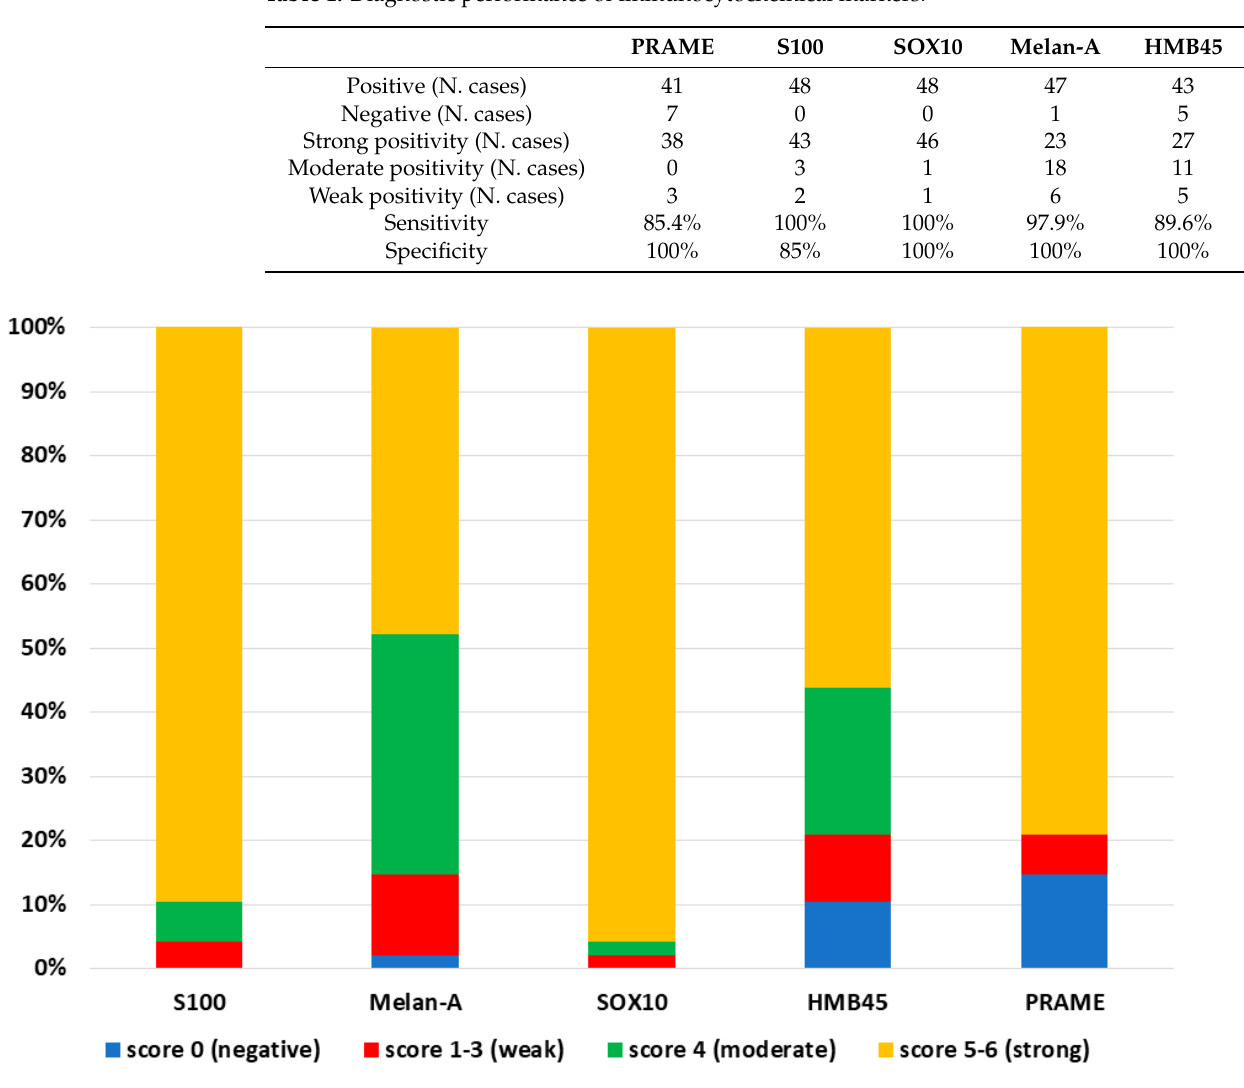
Figure 1. Distribution of staining scores for the immunocytochemistry antibodies. Immunocytochemical stains for S100, Melan-A, SOX10, HMB45 and PRAME were performed in 48 cytological samples of melanoma metastases. S100 and SOX10 were positive in all cases (100%). Melan-A, HMB45 and PRAME were negative in 1 (2.1%), 5 (10.4%) and 7 (14.6%) cases, respectively. SOX10 showed the best diagnostic performance, as strong positivity was observed in 46 (95.8%) cases.